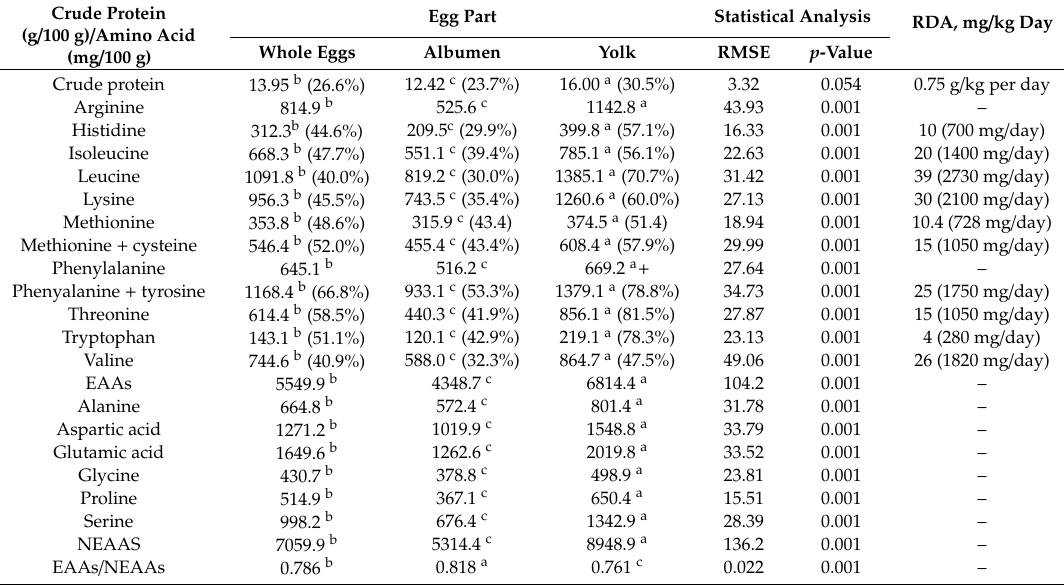
Table 4. Amino acid patterns of di ff erent egg parts in the retail market compared to recommended daily allowance standard Food and Agriculture Organization (FAO) / World Health Organization (WHO) [22] values of adults (70